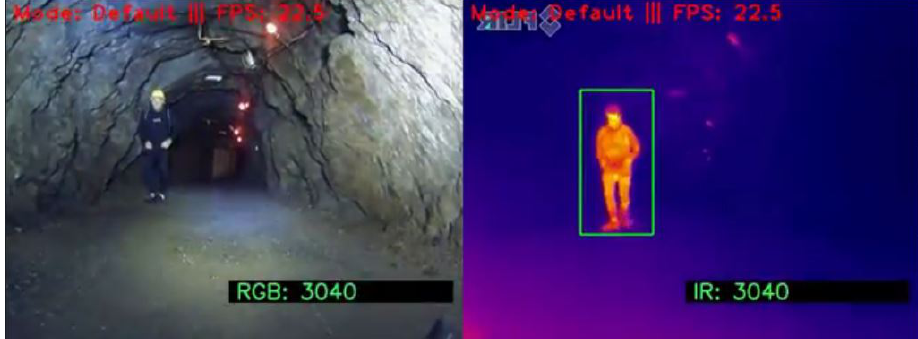
Figure 11. Human in standing position—correct detection with algorithm Histogram of Oriented Gradients (HOG) only in infrared (IR)